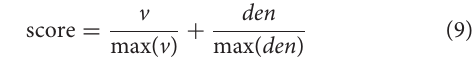
selects the appropriate K -values according to the distribution of samples and adjusts the weights according to the contribution of samples to the